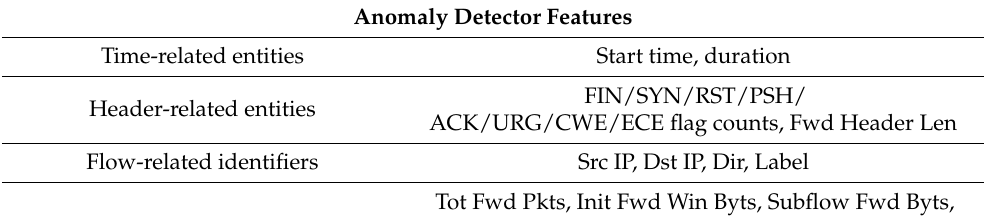
Table 1. Features used for the anomaly detection and the mitigation engine